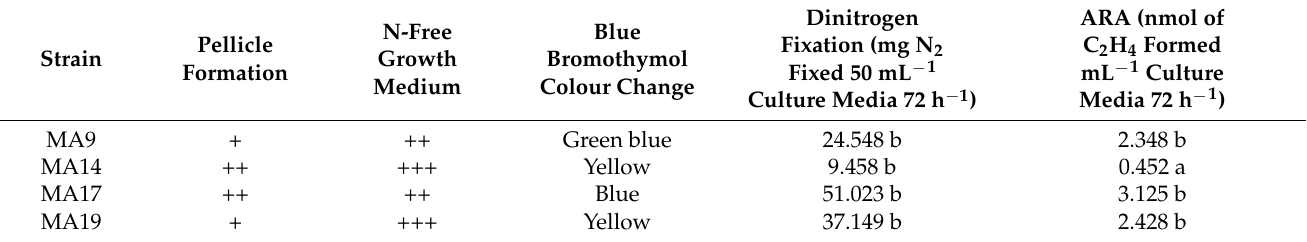
Table 2. Plant growth-promoting attributes of salt-tolerant endophytic bacteria at 2% NaCl